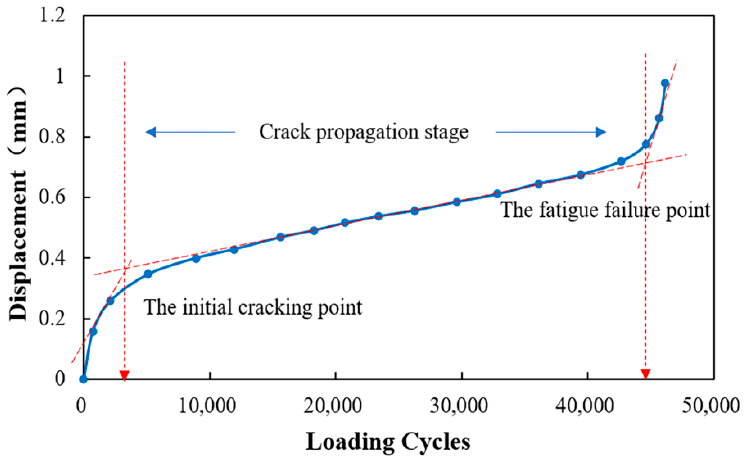
Figure 6. The typical fatigue loading curve of asphalt mixtures. Table 5. The fatigue life of CRME with different curing times under different stress ratios.